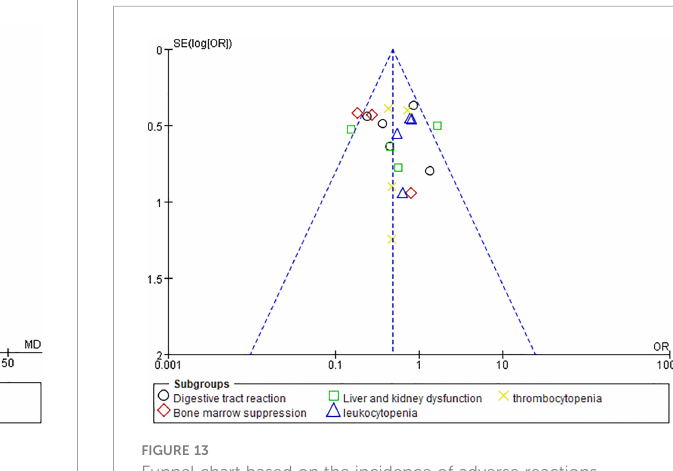
FIGURE 11 Funnel chart based on life quality score.